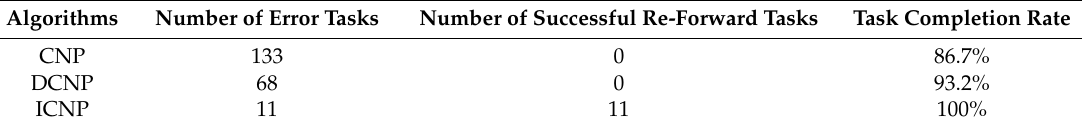
Table 2. Number of errant tasks and task completion rate.